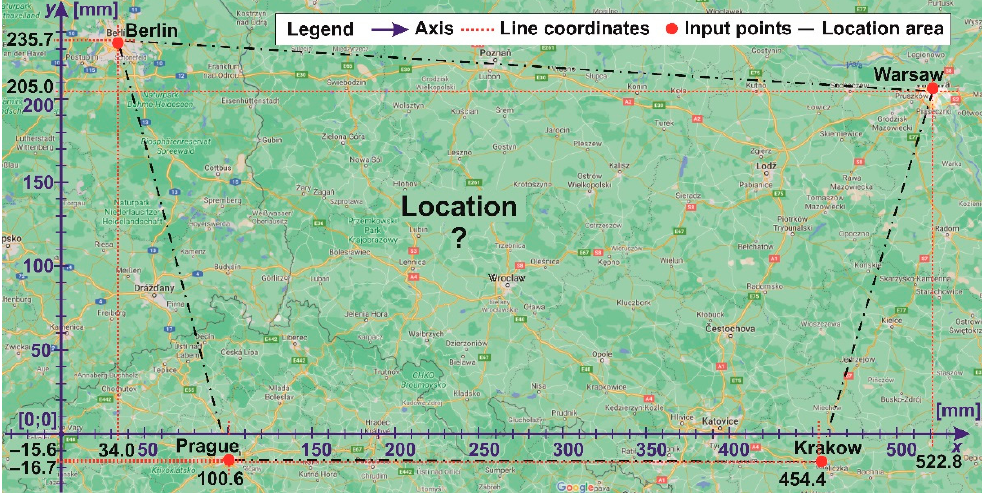
Figure 4. Location of a distribution and supply region in the coordinate system.